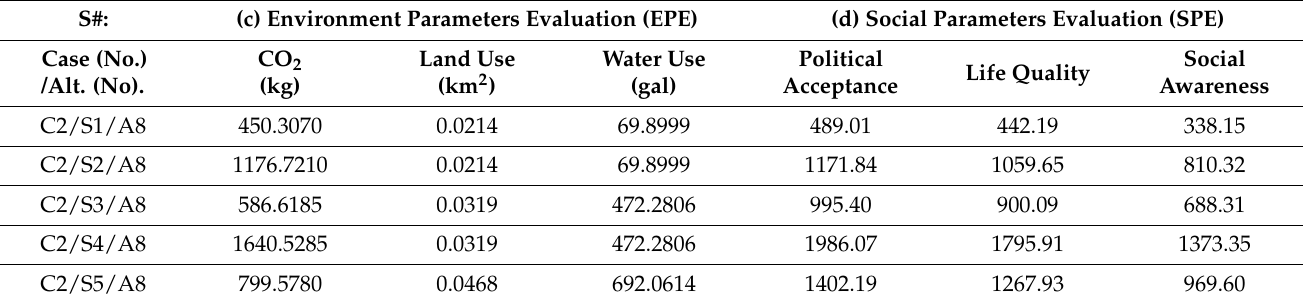
Figure 13. Details of respective TEES evaluations, including MCDM methodologies, are shown in Section S.2.1 in the Supplementary Materials. C2/S1 results in the top three alternatives in terms of UDS. The respective ranks of shown in Figure 13 across C2/S1 under NL as follows: